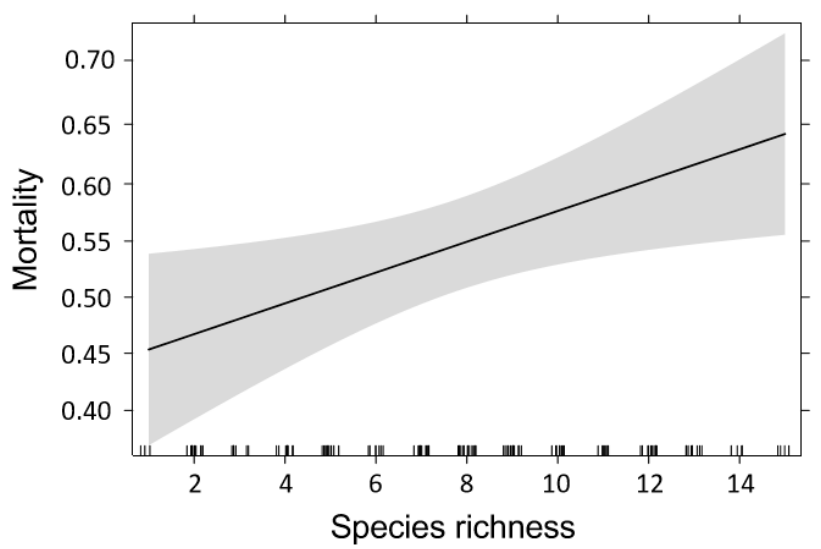
Figure 3. Relationship between total natural enemy species richness and bark beetle mortality. The shaded area indicates the 95 % onfidence band. The rug plots at the bottom of the graph show the values measured in this study. Statistical details are given in Table S1.